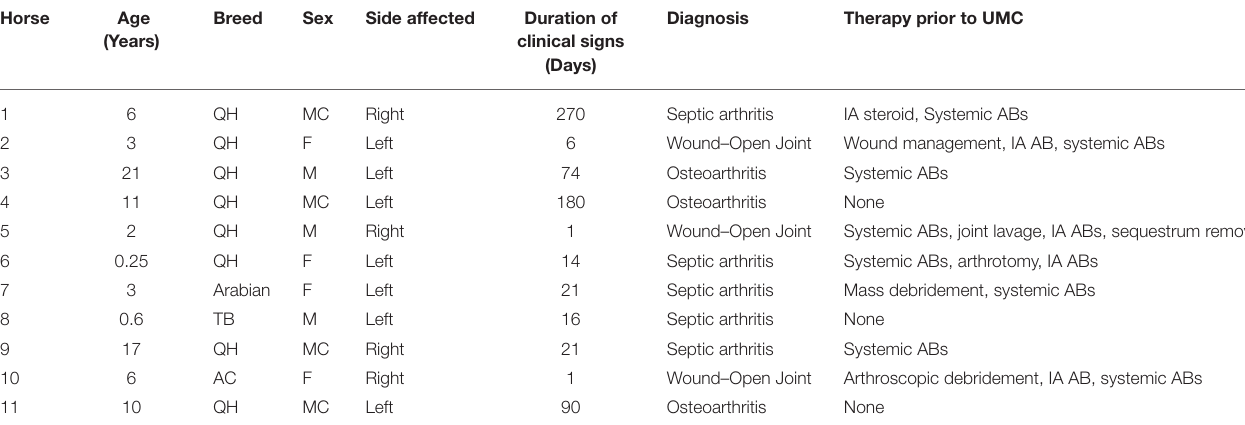
TABLE 1 | Signalment, duration of clinical signs, diagnosis, and prior therapy. Horse